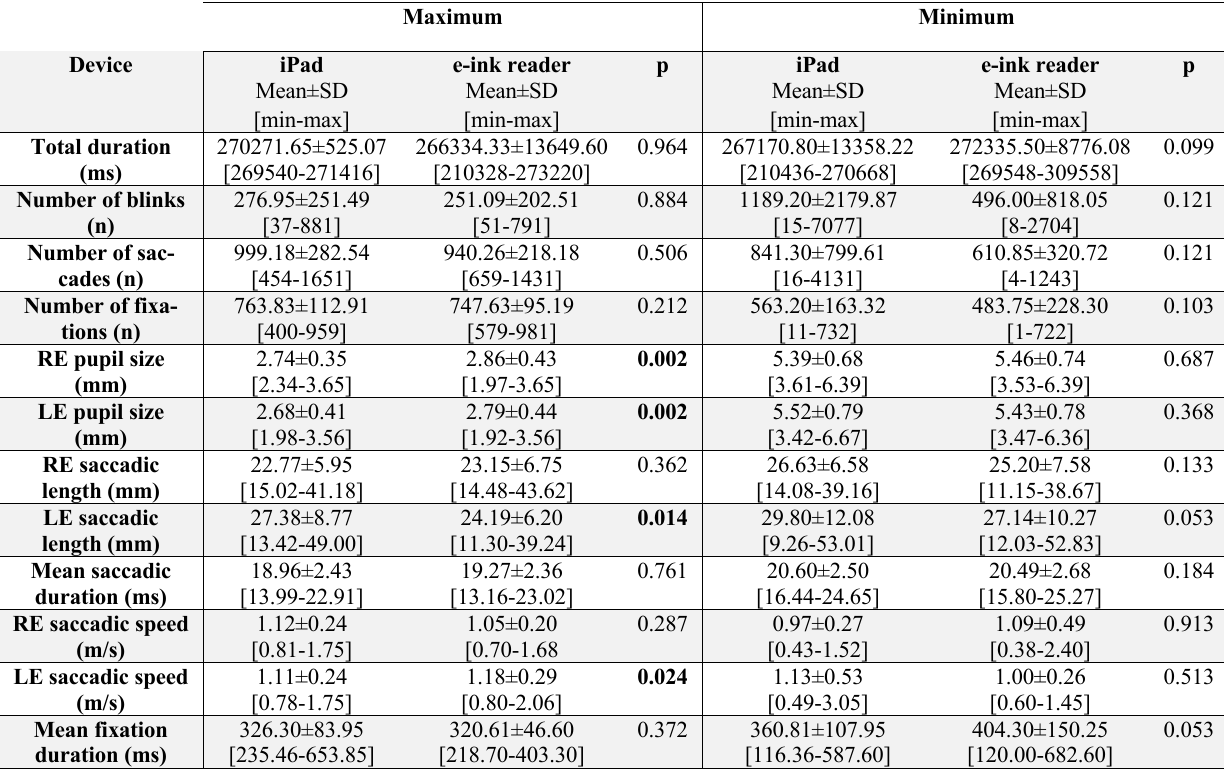
Table 2. Descriptive data and comparison between the two devices for the similar environmental lighting condition regarding the number of blinks, saccades and fixations, right eye’s (RE) and left eye’s (LE) pupillary diameters, length and velocity of the saccade in the RE and LE, and mean duration of saccades and fixations. Mean value±standard deviation (SD); minimum and maximum measured values, the differences are considered statistically significant (marked in bold) when a p-value